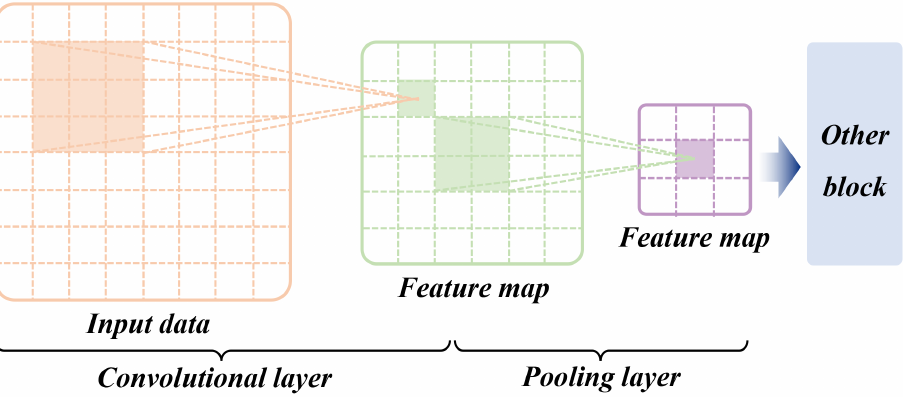
Figure 1. The basic architecture of a typical